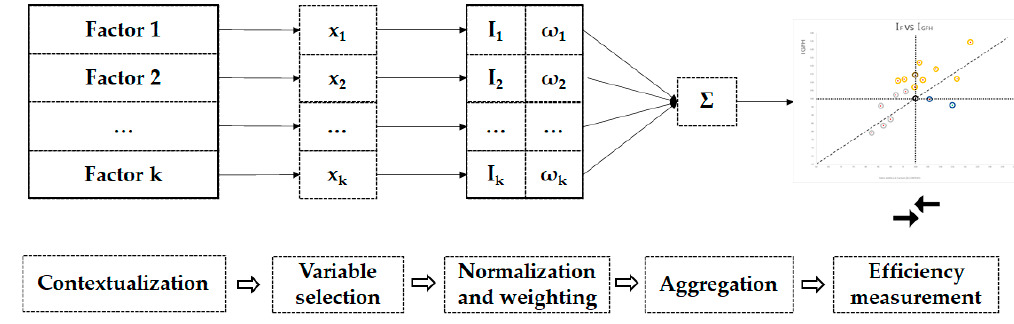
Figure 1. Methodological scheme.